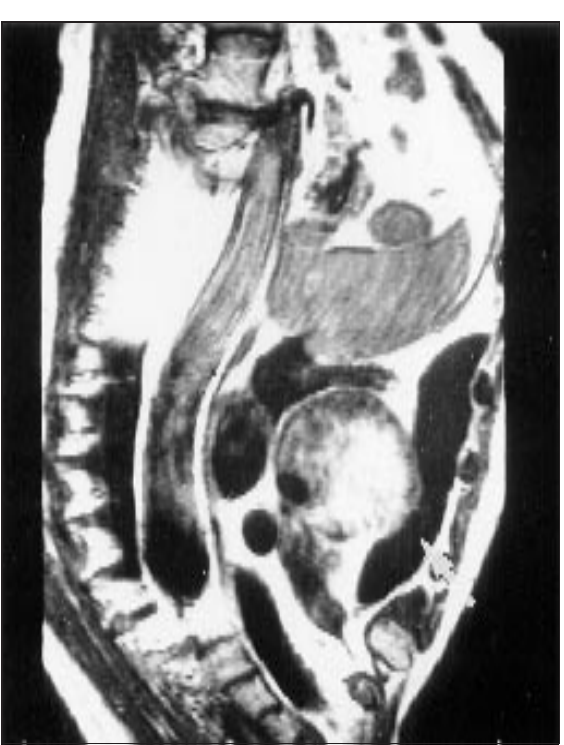
Fig. 3 - Ressonância magnética do tórax mostrando pseudo-aneurisma da aorta